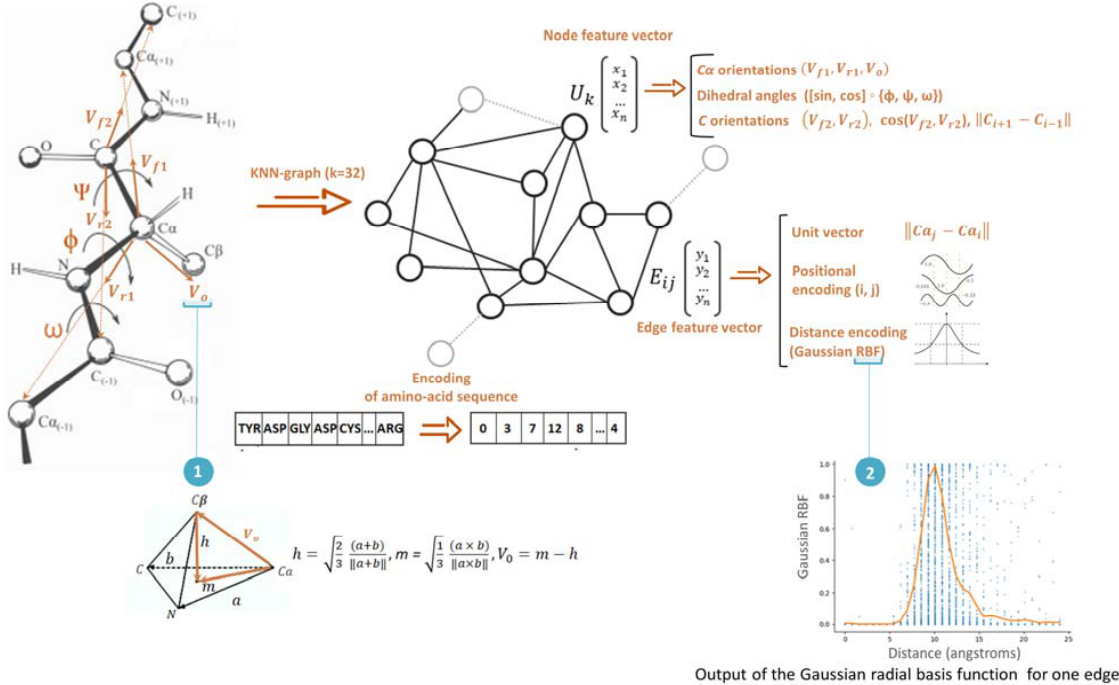
Figure 2. Feature extractions from protein sequences. The graph shows the protein structure.